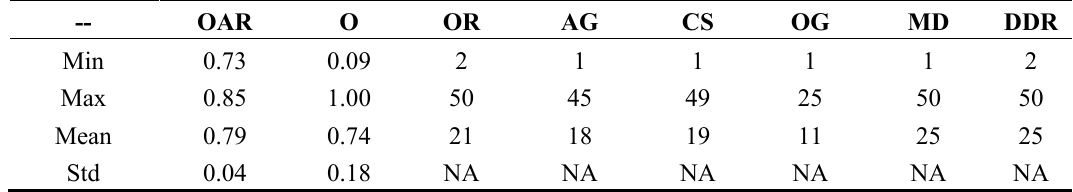
Table 8. Summary statistics on the overall agreement rate (OAR) and omission (O) metrics reported by image date in Table 8. StD = Standard Deviation. All other columns are the same summary statistics of the rank values shown in Table 7. For example, a top 25 performing date had the maximum omission rate (50) and the average ranks for mean depth and depth departures among the top 25 were both 25 (the same as for the entire database). Standard deviations on ranks are not applicable